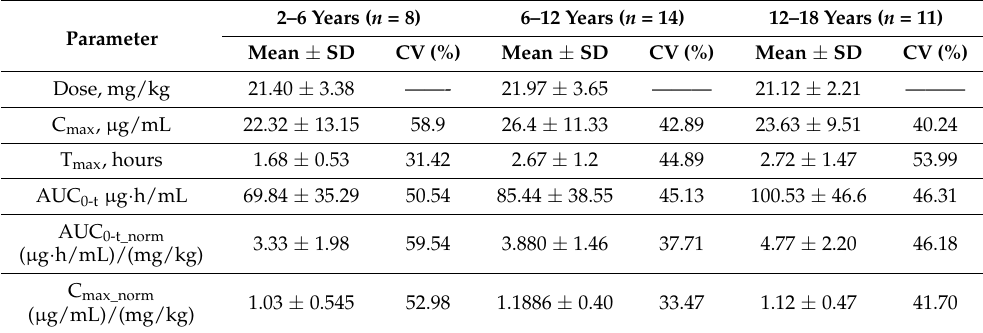
Table 2. Pharmacokinetic parameters of CPF in different age